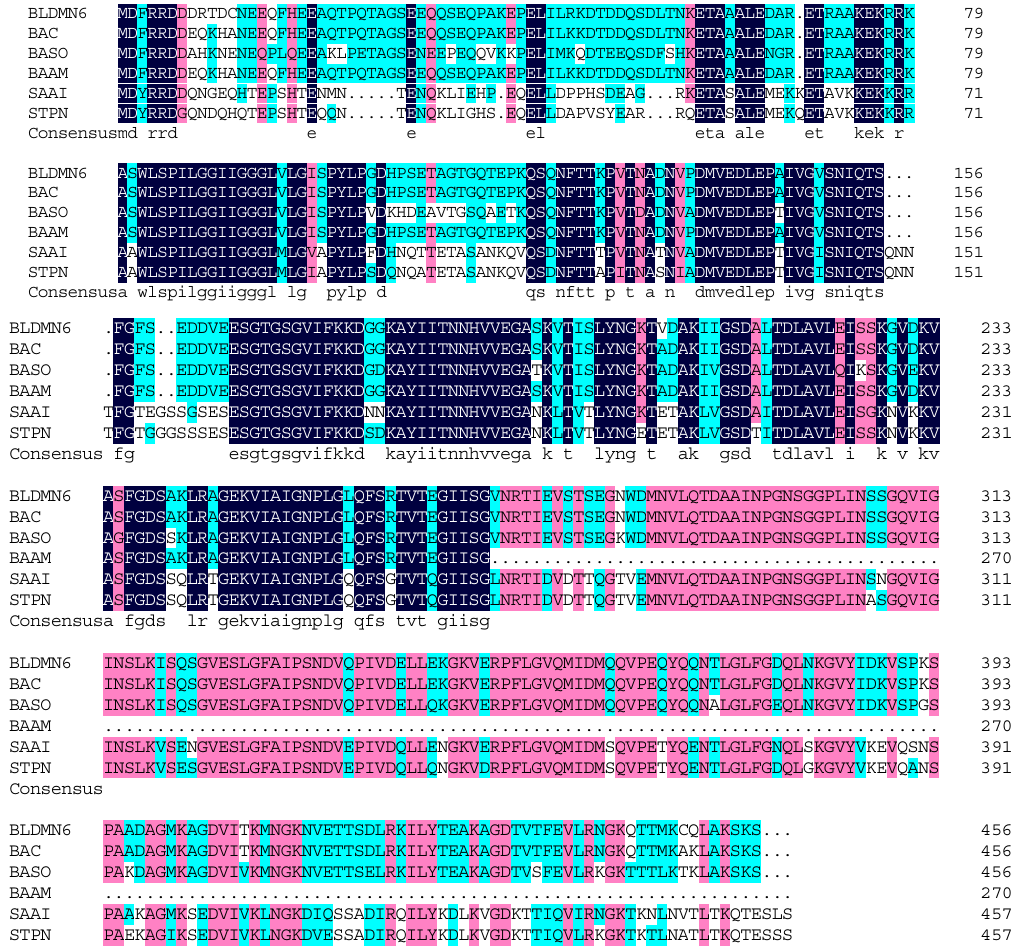
Figure 7. Amino acid sequence alignment of trypsin from different origins. BLDMN6, the trypsin